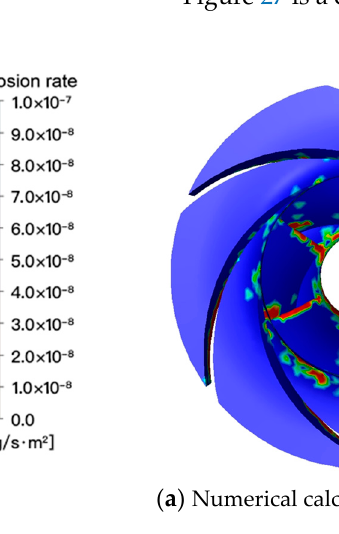
Figure 27 is a comparison of the wear position of the pump inlet position.